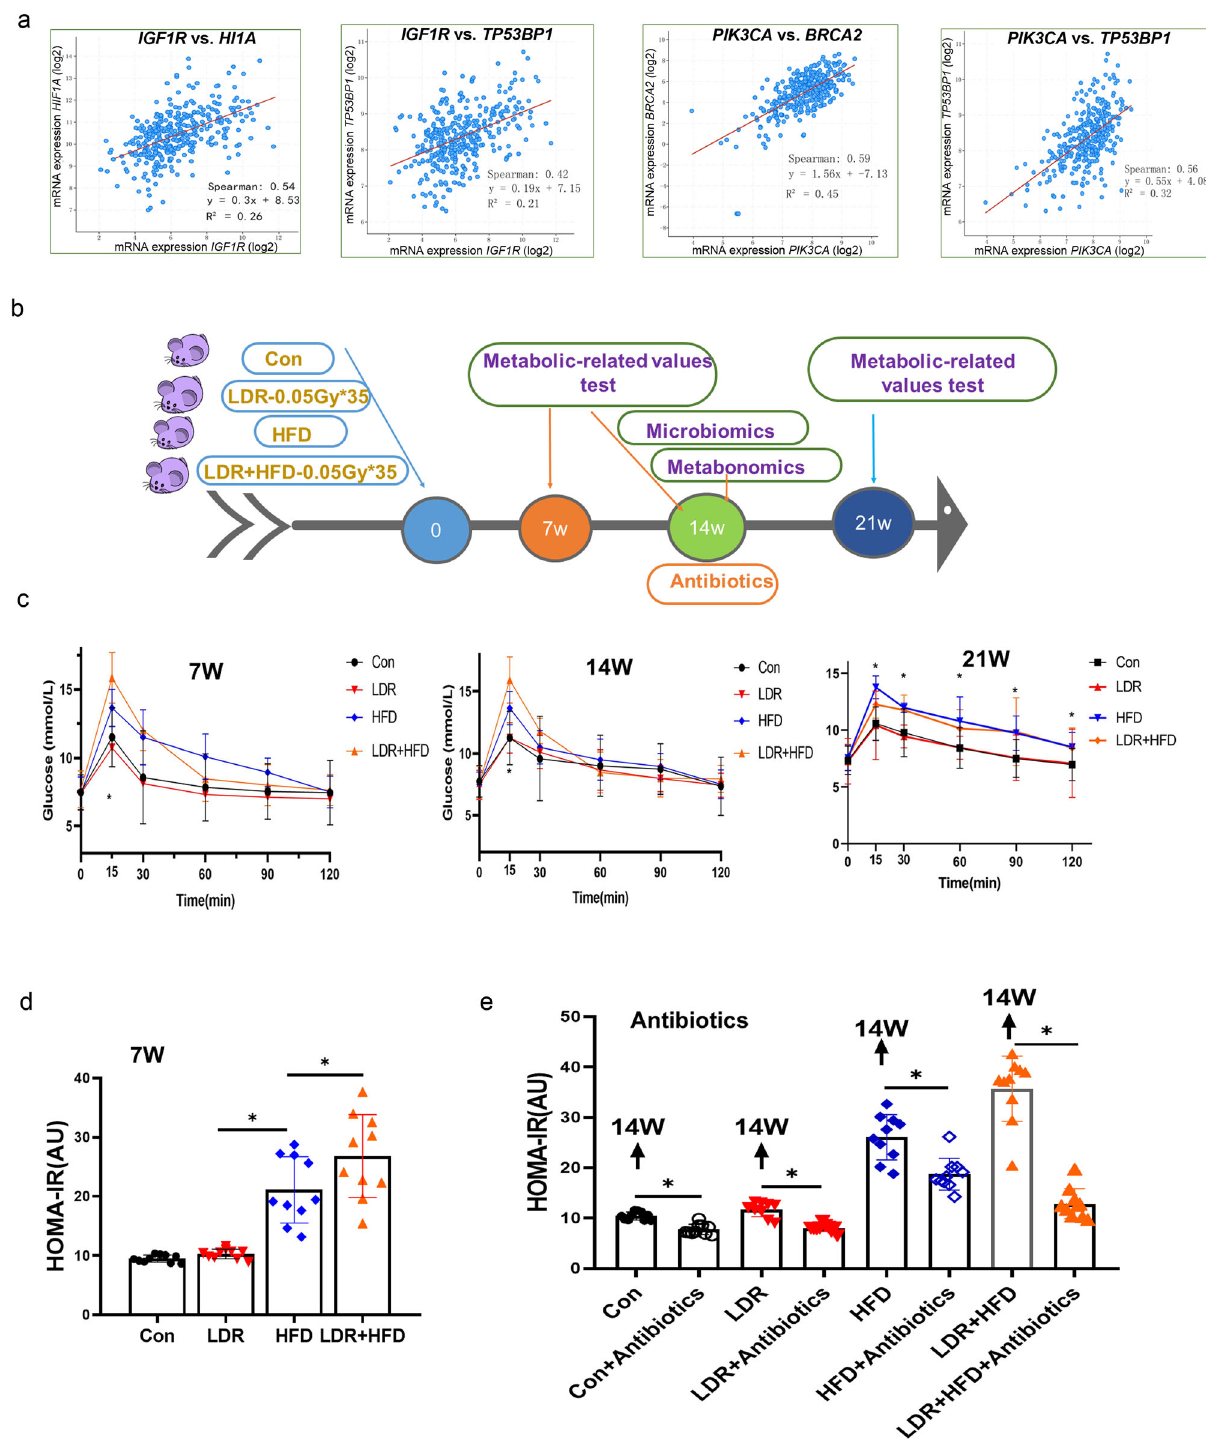
Fig. 1 Cancer patients with T2D treated with radiotherapy (RT) may present stronger metabolic impairment effects than those not treated with RT. a Correlation analyses of radiotherapy-related genes using the online cBioPortal database (http://cbioportal.org), a resource for exploration, visualization, and analysis of complex cancer genomics and clinical pro fi le data from TCGA. b Timeline for the mice subjected to HFD, LDR (0.05 Gy*10) or LDR (0.05 Gy*10) + HFD. c Blood glucose levels at the indicated time points among the Con, LDR, HFD and LDR + HFD groups. d HOMA-IR values at the indicated time points among the Con, LDR, HFD and LDR + HFD groups. e Mice were administered an antibiotic cocktail (50 g/L penicillin G sodium, 50 mg/L metronidazole, 100 U/L streptomycin, and 0.4 g/L neomycin sulfate) in their drinking water for 14 days, after which the mice were subjected to LDR, HFD or LDR + HFD treatment. The mice were killed at 14 weeks, and the HOMA-IR values were detected. The data are the means ± standard deviations (SDs). The Mann-Whitney test or two-tailed unpaired Student ’ s t-test was used for statistical analyses. * p < 0.05 indicates a signi fi cant difference. Error bars indicate SEM (standard error of the mean). b was created by Ruixue Huang.